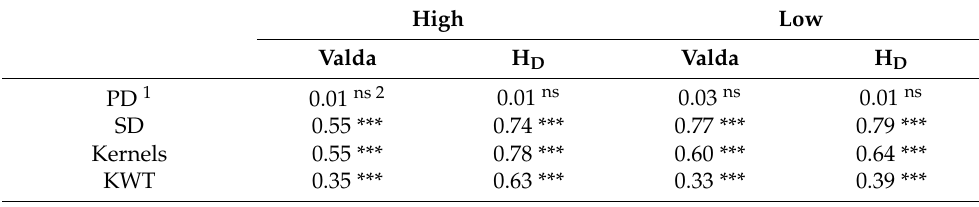
Table 10. Cultivar Valda and H D in four high (>5000 kg ha − 1 ) and five low (<5000 kg ha − 1 ) yield environments with partial correlation coefficients (r) and significance for relationships between the yield and yield components and the corresponding standardized multiple linear regression equations. High Low Valda H